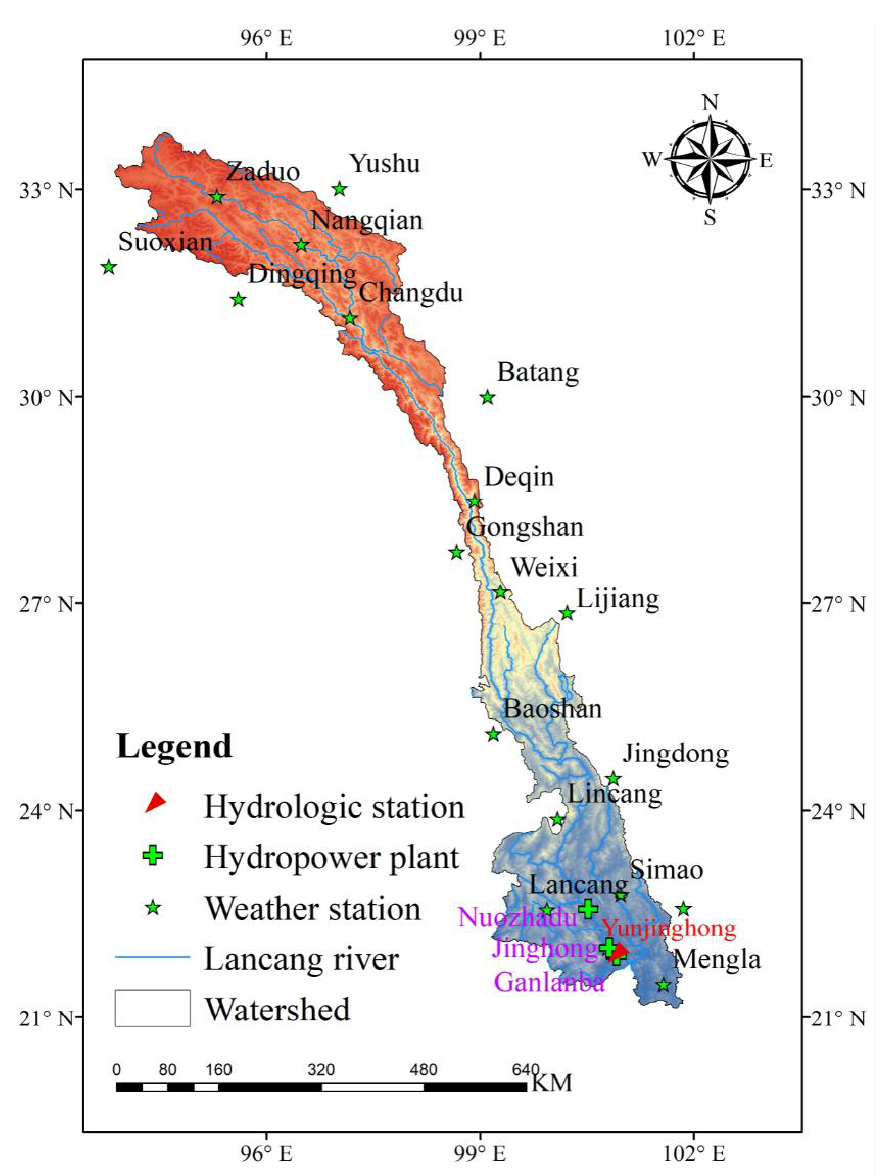
Figure 1. The watershed of the Lancang River.